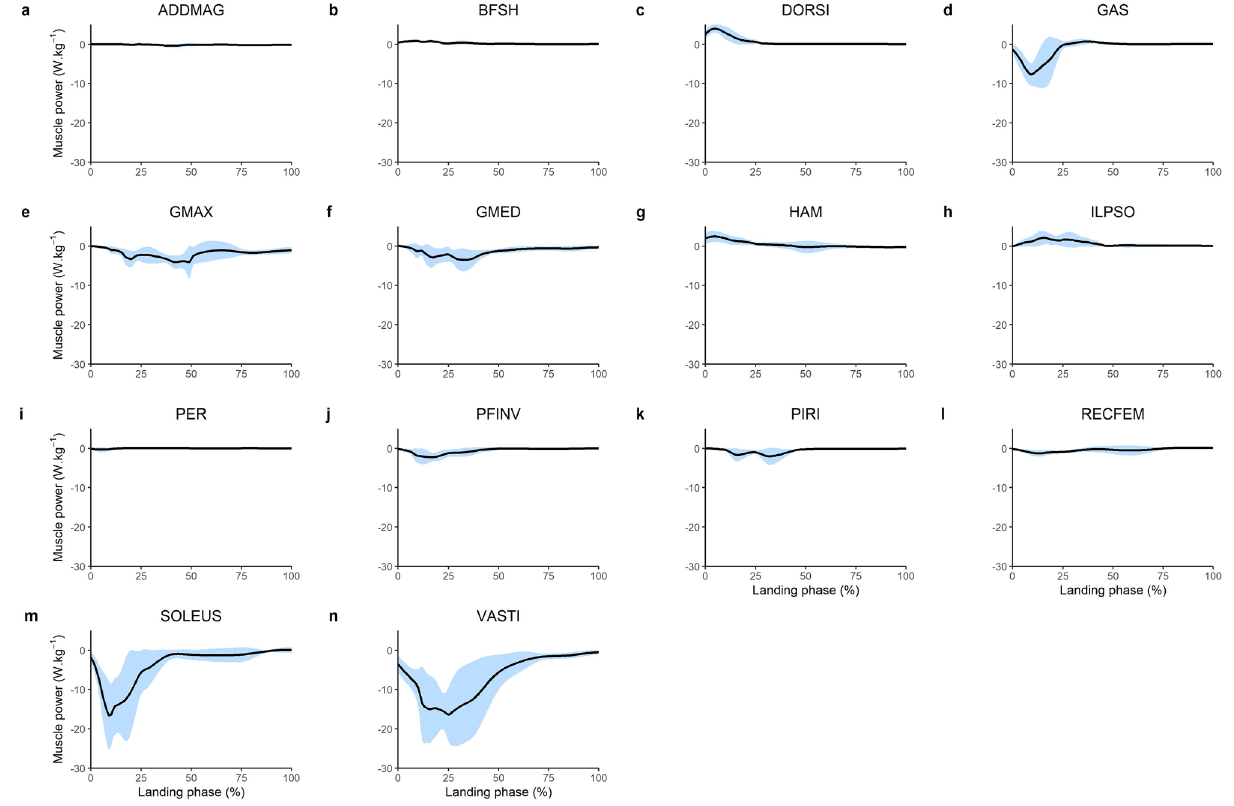
Figure 2. Mean (black line) and SD (blue shaded) body mass normalised lower limb musculotendinous mechanical power for the landing phase (initial contact to peak knee flexion) of a single-leg drop landing from a 0.31 m height. ADDMAG, adductor magnus; BFSH, biceps femoris short head; DORSI, ankle dorsiflexors (sum of tibialis anterior, extensor hallucis and digitorum longus); GAS, gastrocnemius (sum of lateral and medial gastrocnemius); GMAX, gluteus maximus; GMED, gluteus medius (sum of gluteus medius and minimius), HAM, biarticular hamstrings (sum of biceps femoris long head, semimembranosus, and semitendinosus); ILPSO, iliopsoas (sum of iliacus and psoas major); PER, peroneus (sum of peroneus longus and brevis); PFINV, plantar flexor invertors (sum of tibialis posterior, flexor hallucis and digitorum longus); PIRI, piriformis; RECFEM, rectus femoris; SOLEUS, soleus; VASTI, vasti (sum of vastus intermedius, lateralis and